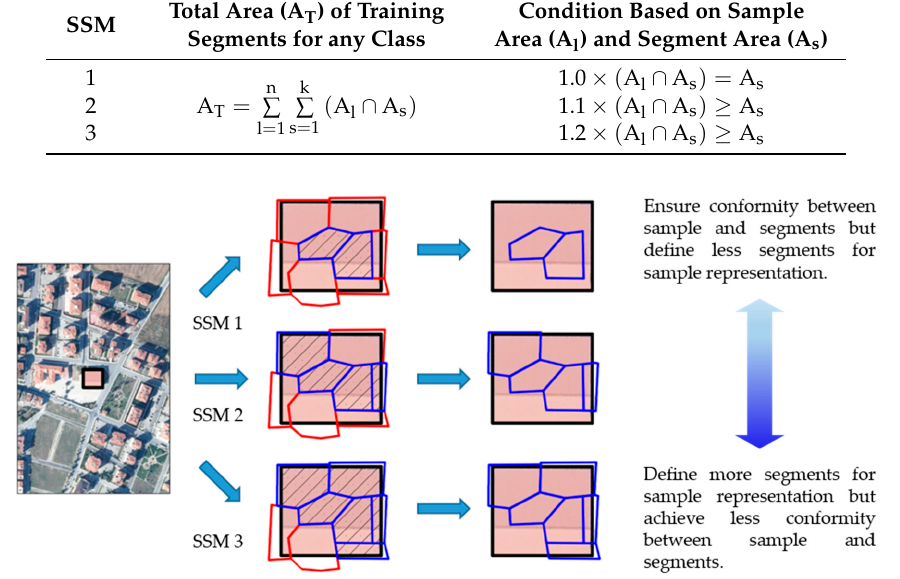
Table 4. Three criteria for training segment definition.